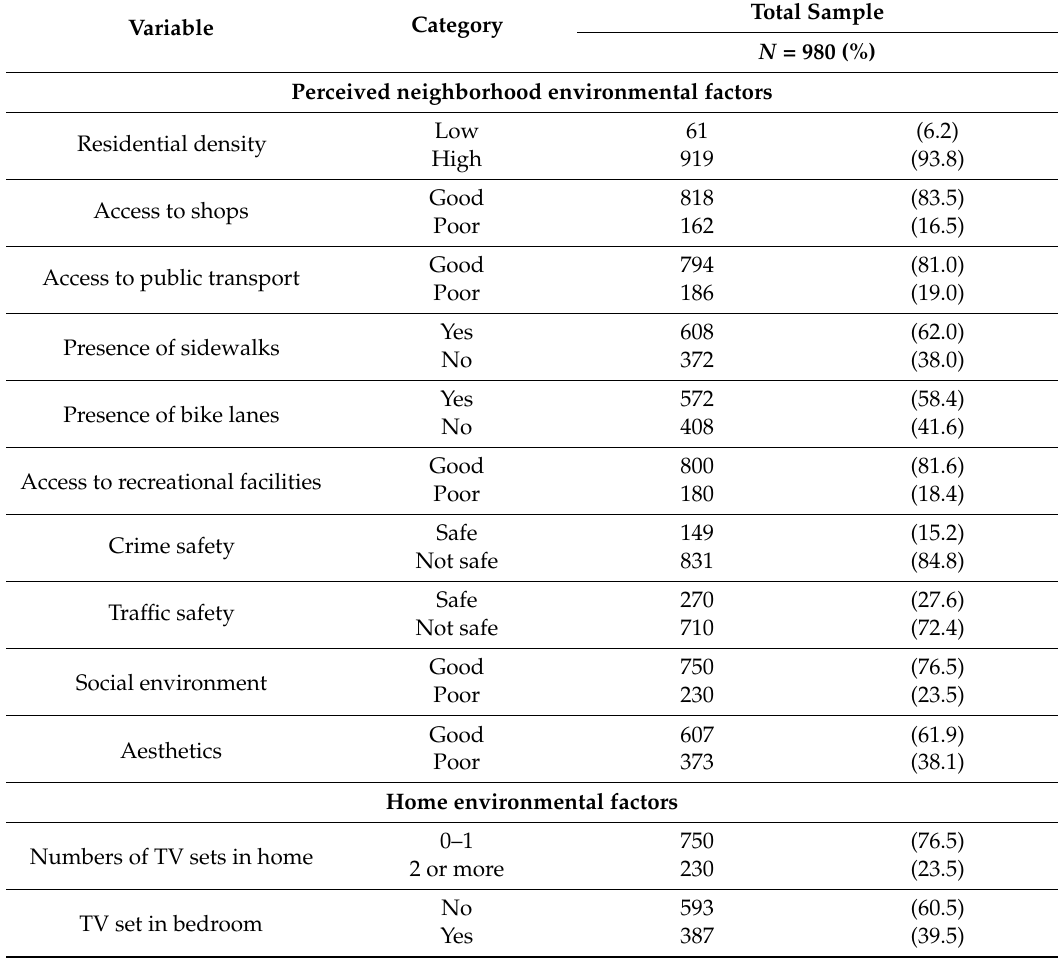
Table 3. Descriptive Statistics of Perceived Neighborhood and Home Environmental